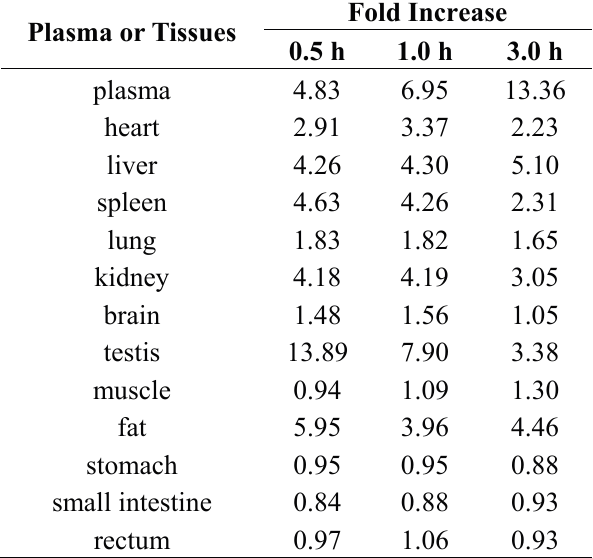
Table 4. Fold increase in plasma or tissues of caudatin in HCC model rats vs conventional rats (n =